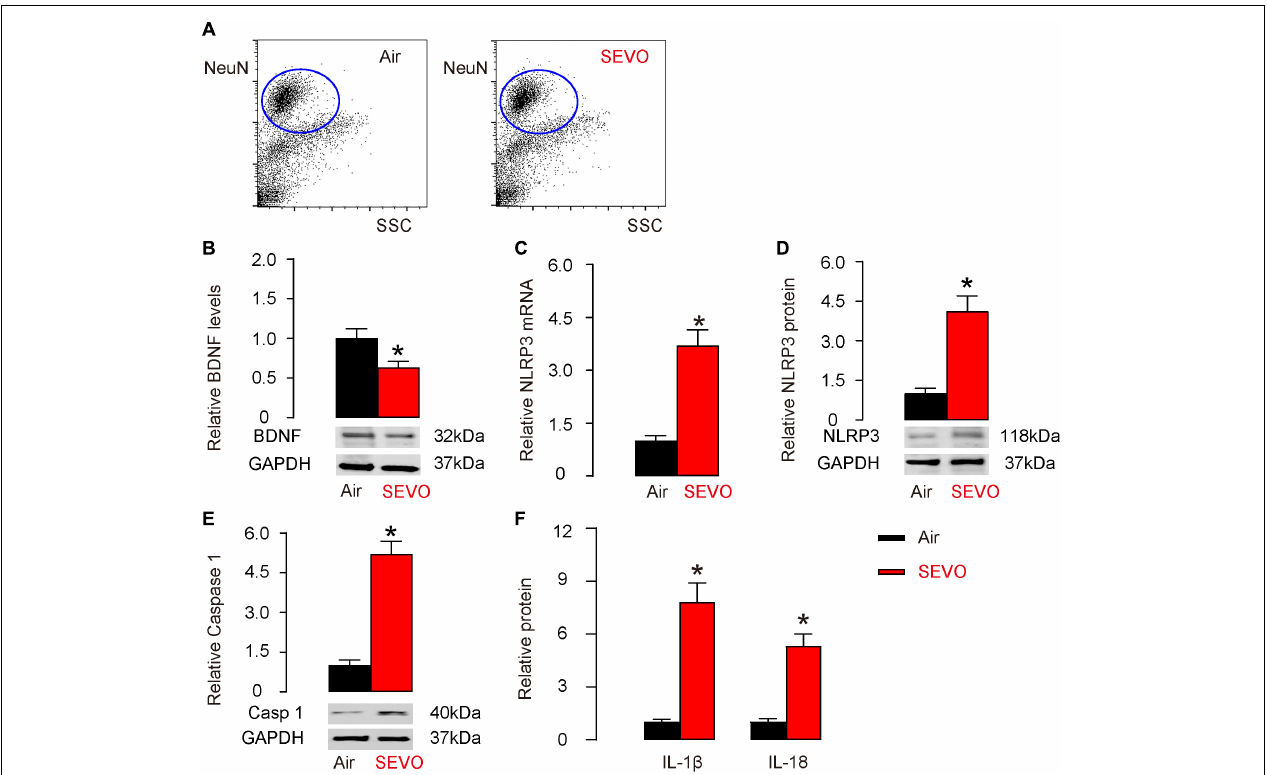
FIGURE 3 | SEVO reduces BDNF and increases NLRP3 inflammasome in neuronal cells. (A) Representative flow charts for isolation of NeuN-positive neuronal cells from mouse hippocampus by flow cytometry. (B) Western blot for BDNF in neuronal cells from SEVO-exposed mice, compared to those from air-control mice. (C,D) RT-qPCR (C) and Western blot (D) for NLRP3 in neuronal cells from SEVO-exposed mice, compared to those from air-control mice. (E) Western blot for caspase 1 in neuronal cells from SEVO-exposed mice, compared to those from air-control mice. (F) ELISA for IL-1 β and IL-18 in neuronal cells from SEVO-exposed mice, compared to those from air-control mice. * p < 0.05. N = 10. N represents mouse number per experimental